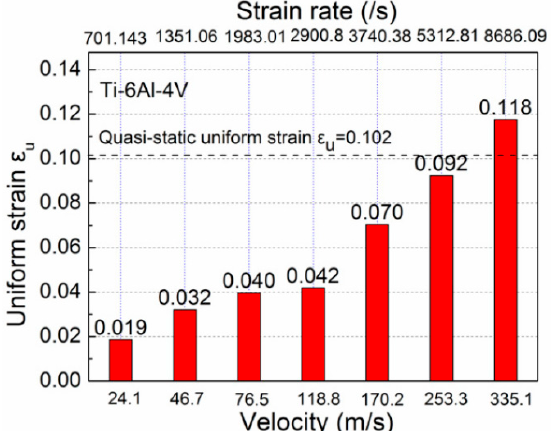
Figure 3. Relationship between strain rates, deformation velocities and uniform strain of Ti-6Al-4V